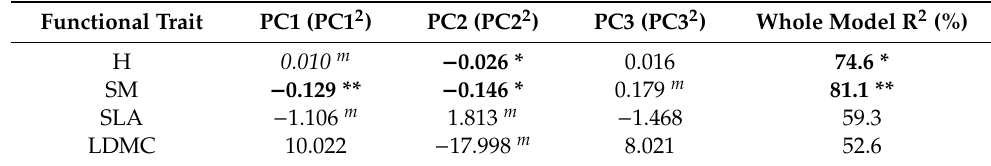
Table 3. Results from multiple linear regression models applied to the community-weighted means of four traits (height—H, seed mass—SM, specific leaf area—SLA, leaf dry matter content—LDMC) and three predictor variables (PC1, PC2, PC3 and / or their quadratic terms). Averaged site-level data from large (10 × 10 m, n = 10) plots were used. Reported values are parameter